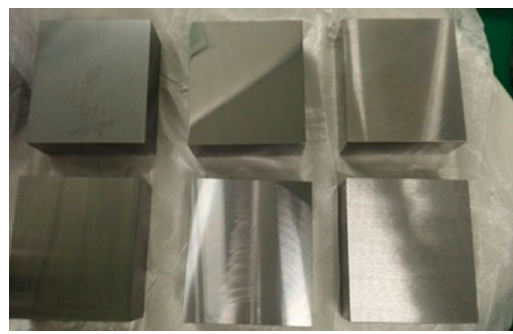
Figure 2. Specimens.